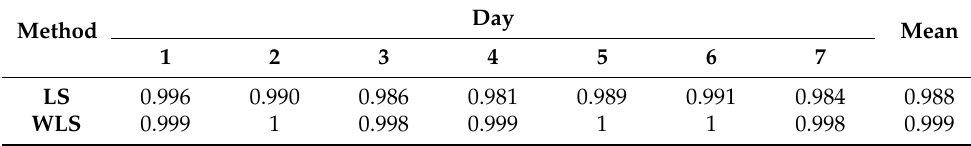
Table 4. Integer ambiguity resolution success